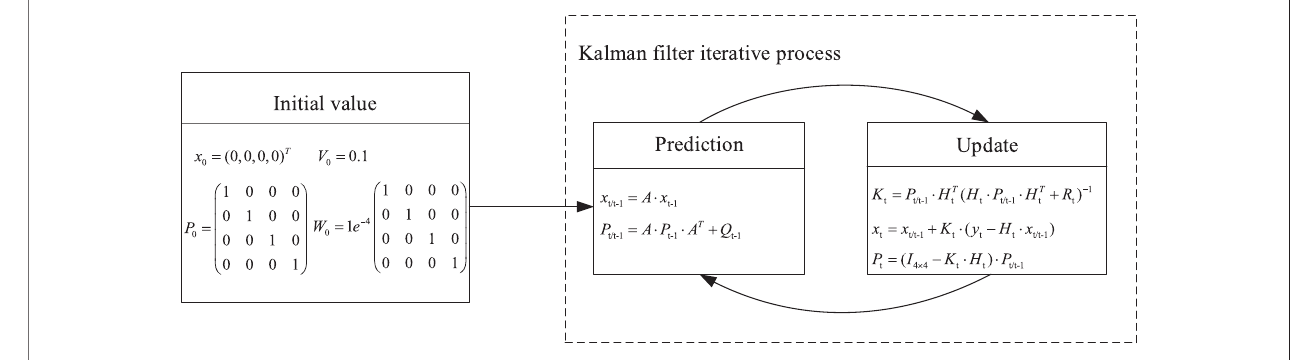
FIGURE 7 | Kalman fi lter PV power prediction fl ow.